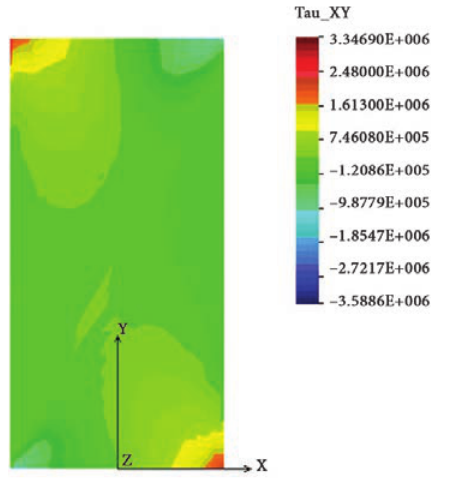
Fig. 5. Distribution of shear stress component τ xy in the sample with fixed ends